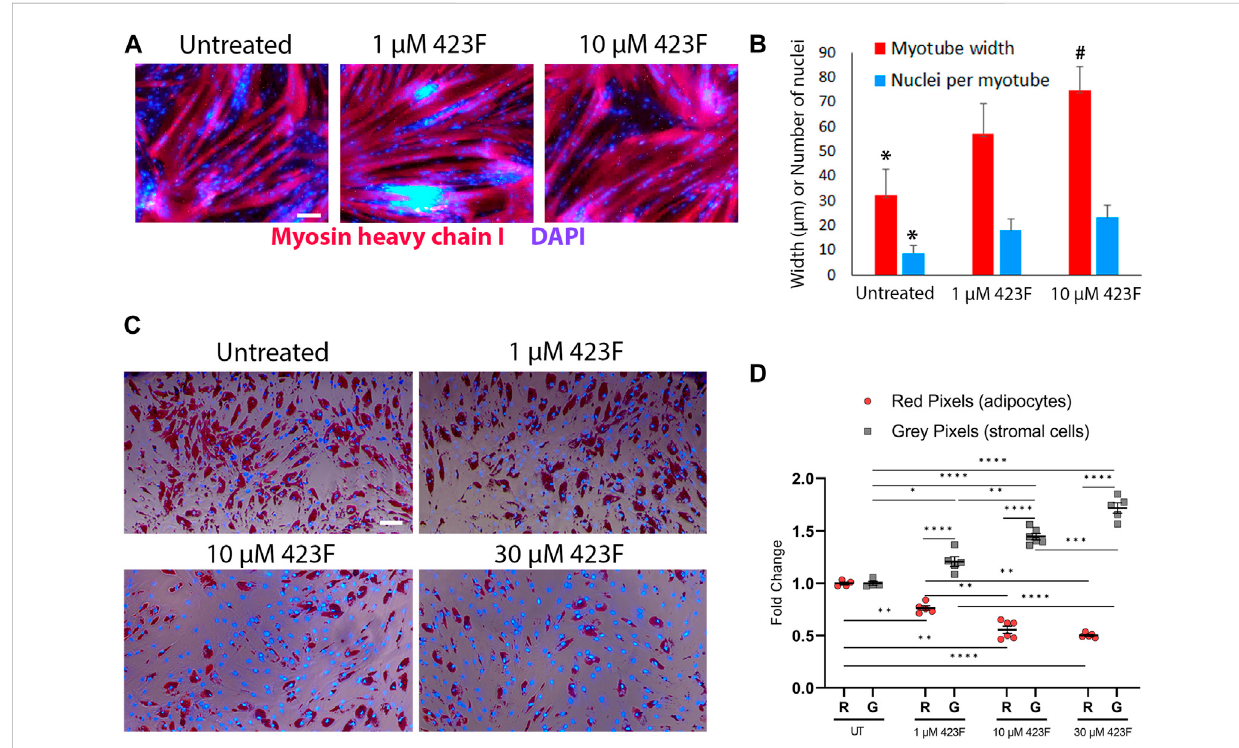
FIGURE 8 Different effects of 423F treatment on differentiated muscle progenitor derivatives. (A, B) Analysis of MyHC I + myotube maturation based on myotube diameter and number of nuclei per myotube as seen in representative images of untreated and 423F treated cultures of CD56 + CD90 + progenitors (A) and matched measurements (B) . Graphs represent mean ± SEM. n = at least 3 donors. Data analyzed via one-way ANOVA. * p < 0.001between423Ftreatedculturesanduntreatedcontrolcultures,# p < 0.0000001between1 µMtreatedculturesand10 µMtreatedcultures. (C, D) Survivalofhumanmuscle-derivedmatureadipocytes(OilredO + DAPI + cells)andFAP(grayDAPI + cells)inmixedculturesintheabsenceorpresenceof increasing concentrations of 423F. Blue nuclear staining for DAPI and Oil red O staining for adipocytic lipid droplets (C) . Percentage of red pixels (adipocytes) and gray pixels (FAP) out of total area of images of 423F treated cultures (D) . Data was analyzed via paired one-way ANOVA for comparisons between 423F concentrations between the same cell and unpaired Student ’ s t test for comparisons between adipocytes and stromal cells, followed